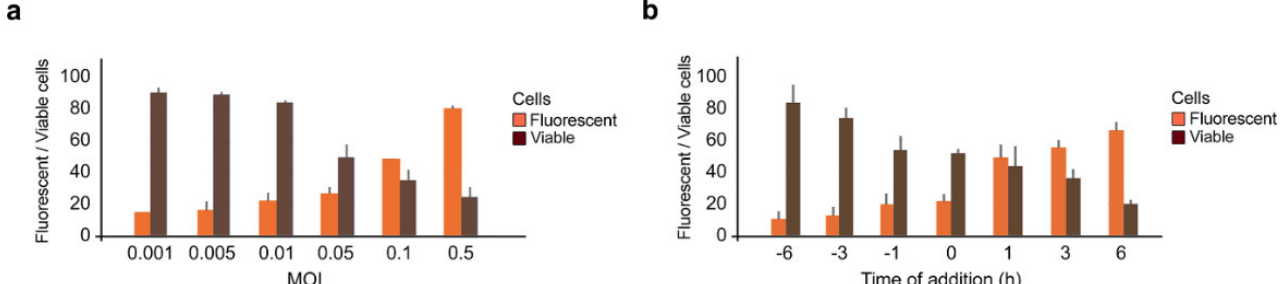
Figure 3. Antiviral activity of IFNα2a depends on moi of SARS-CoV-2-mCherry and time of drug administration. ( a ) Calu-3 cells were treated with 1 μg/mL IFNα2a and infected with indicated moi of SARS-CoV-2-mCherry. Fluorescence intensity and cell viability were measured after 48 h (Mean ± SD; n = 3). ( b ) Calu-3 cells were treated with 1 μg/mL IFNα2a prior, simultaneously, or post infection with SARS-CoV-2-mCherry (moi = 0.01). Fluorescence intensity and cell viability were measured after 48 h (Mean ± SD; n = 3).